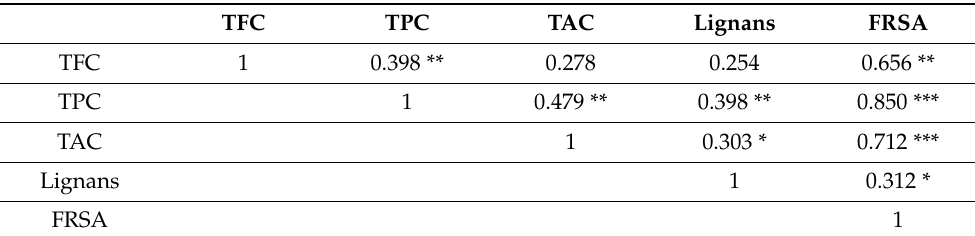
Table 2. Correlation coefficients among the biochemical traits studied in 13 M 3 sesame mutants and their wild-type parents. TFC TPC TAC Lignans FRSA TFC 1 0.398 ** 0.278 0.254 0.656 ** TPC 1 0.479 ** 0.398 ** 0.850 *** TAC 1 0.303